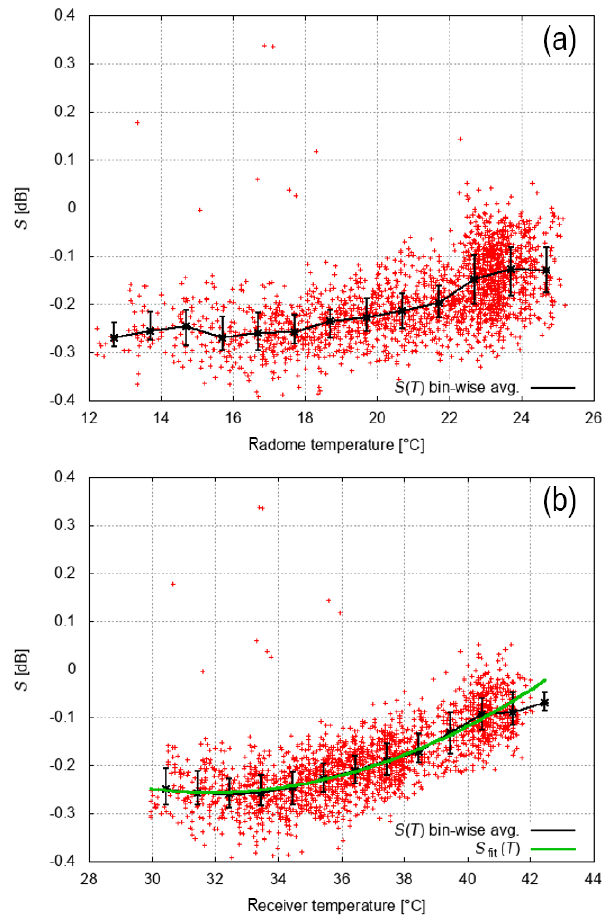
Figure 13. S scatter plot as a function of radome temperature (a) and LNA temperature (b) . LNA temperature is a good proxy for the temperature variations within the receiver box. Also shown is the bin-wise-average ( S(T ) bin-wise avg; 1 ◦ width and the first and third quartiles of all values within this bin) and a polynomial fit of second order ( S fit (T ) ; see also text) of S versus LNA tempera- ture (b) . In total 2157 box scans are used for this analysis.